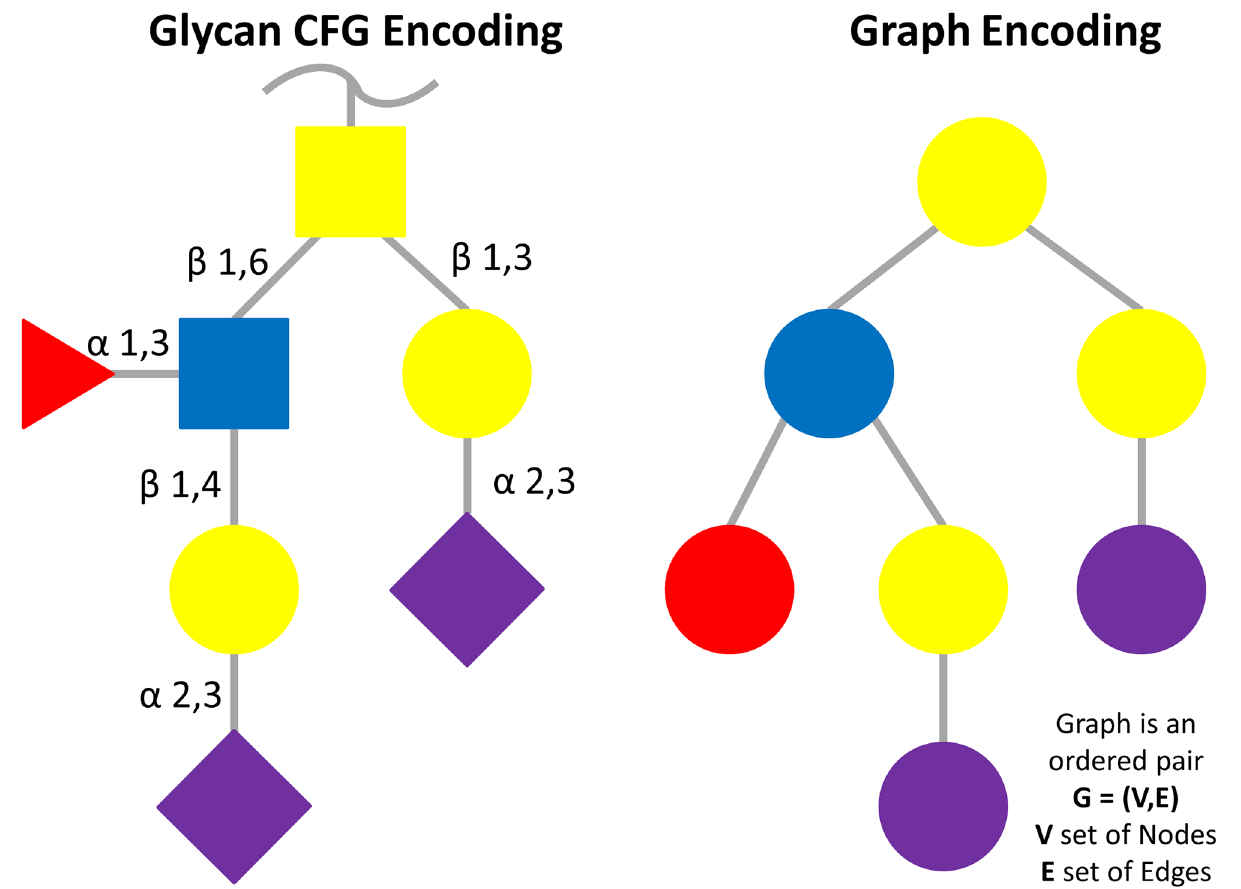
Fig 1. Glycan CFG encoding and graph encoding. On the left hand side a glycan structure encoded with CFG nomenclature is presented, while the right hand side shows the same structure translated into a graph. Each monosaccharide or substituent becomes a node and each glycosidic bond becomes an edge in the graph. Avoiding any loss of information all the properties of each monosaccharide or substituent are converted in node properties whereas glycosidic bond properties are translated in edge properties. To be more clear the colour code associate with the monosaccharide type is preserved among the